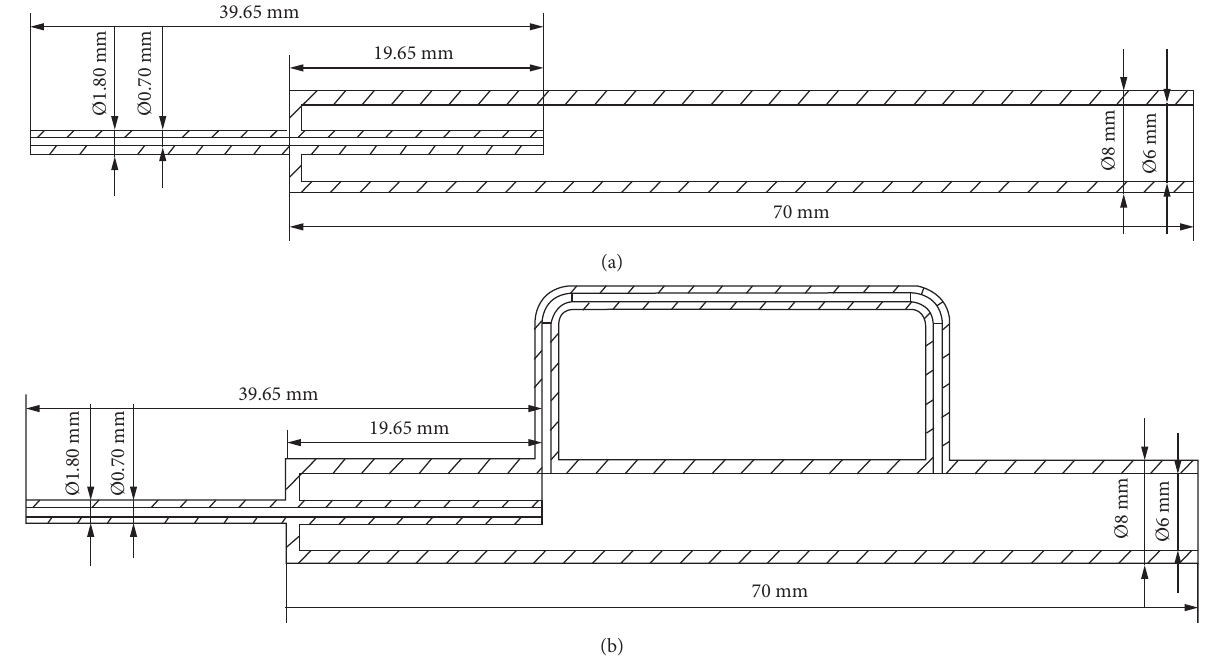
Figure 4: Transition pipe of the refrigeration system. (a) Transition pipe and (b) transition pipe equipped with aeration device.